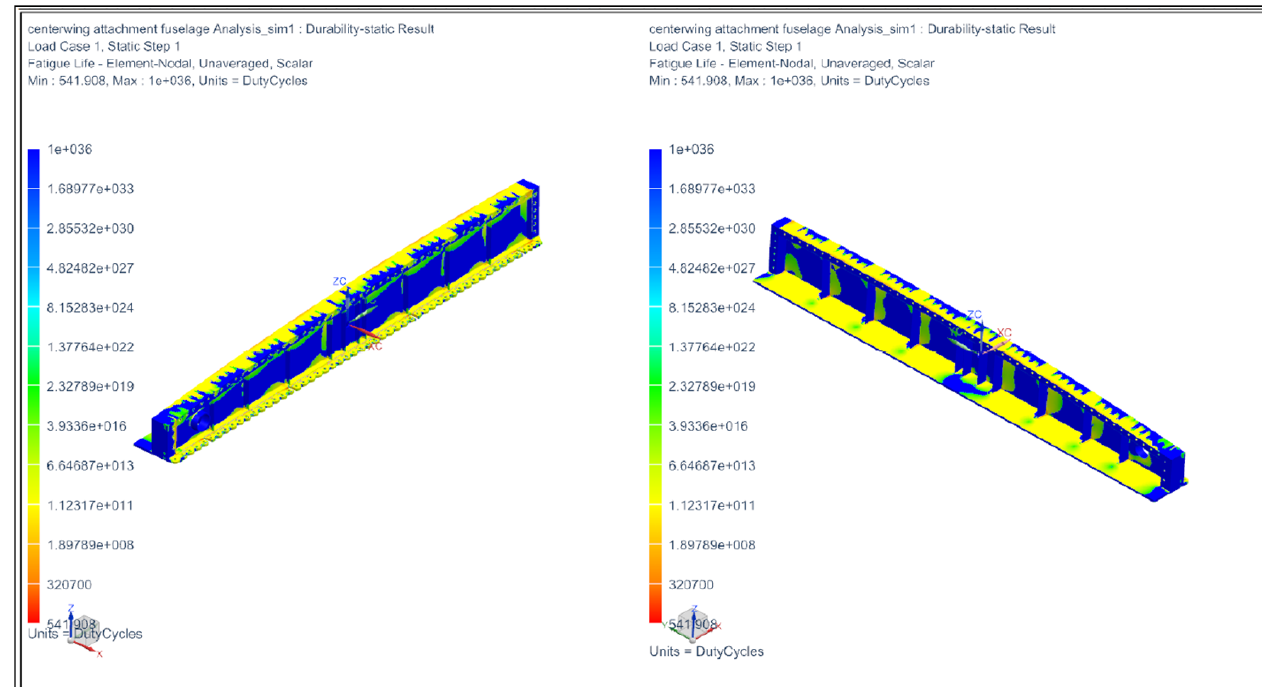
Figure 11. Finite Element Analysis of the wing root joint.